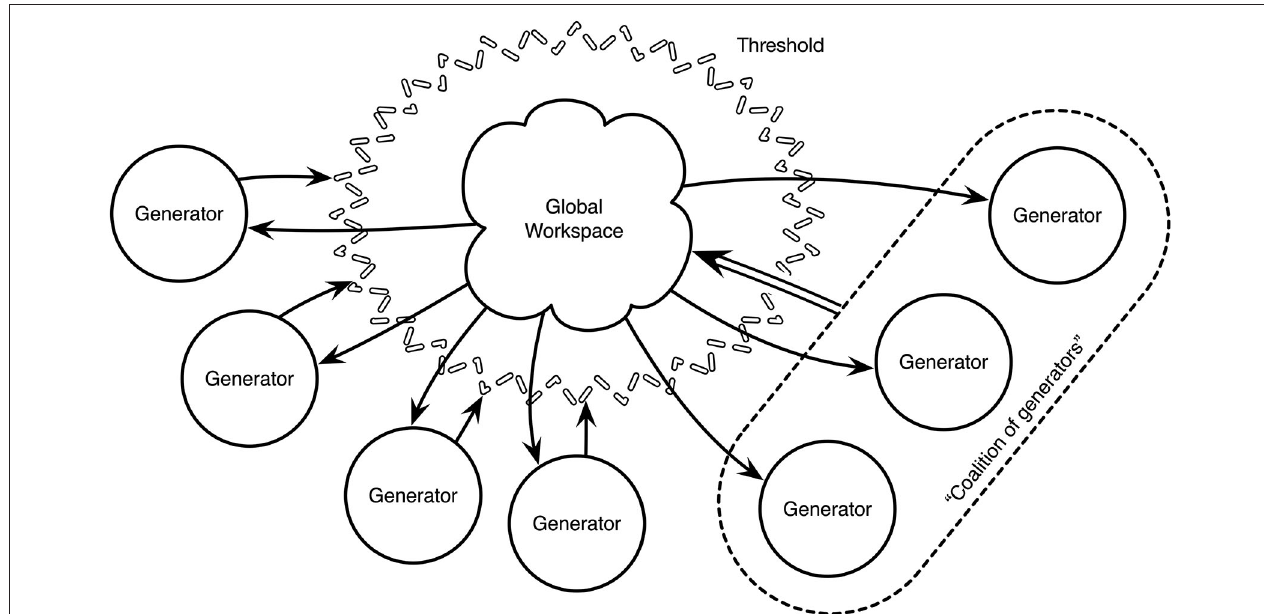
possible only via the Global Workspace. However, before it can be made possible, support from the generators that are to be recruited are needed, and therein lies the